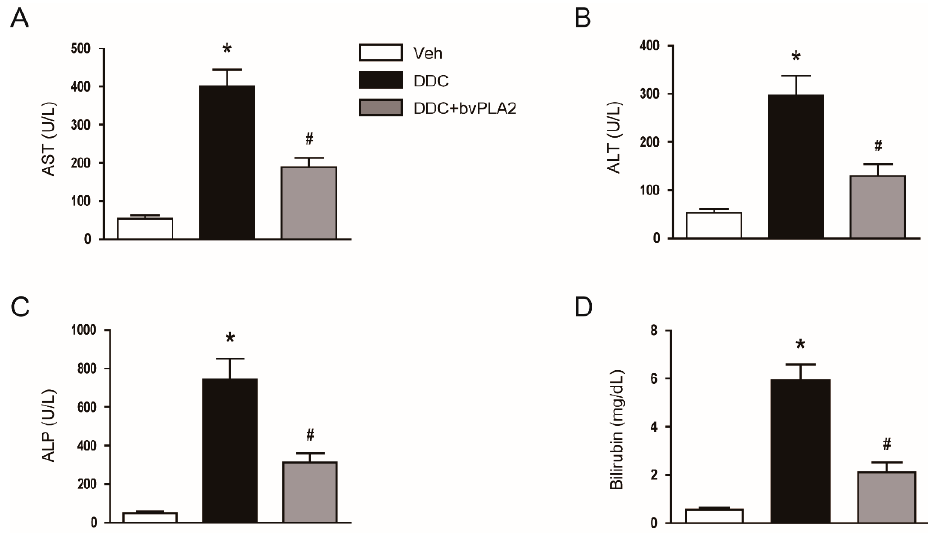
Figure 1. Biochemical markers of liver injury and cholestasis in all study groups. C57BL/6N mice were fed with a diet containing 0.1% 3,5-diethoxycarbonyl-1,4-dihydrocollidine (DDC) and were intraperitoneally injected with bee venom-derived secretory phospholipase A2 (bvPLA2; 0.2mg/kg) twice a week for four weeks. ( A ) Serum aspartate aminotransferase (AST) levels. ( B ) Serum alanine aminotransferase (ALT) levels. ( C ) Serum alkaline phosphatase (ALP) levels. ( D ) Serum total bilirubin levels. n = 8 per group. * p < 0.05 vs. the vehicle-treated control group (Veh). # p < 0.05 vs. the DDC diet-fed group (DDC).